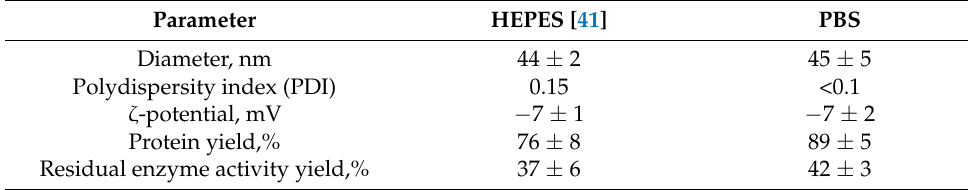
Figure 1. Physicochemical properties of Nano-SOD1 obtained. ( A ) Principal scheme for the synthesis of Nano-SOD1. ( B ) Particle hydrodynamic diameter distribution (SOD1/protamine/PGlu-PEG = 1:2:2 with glutaraldehyde (GA) as a cross-linker). ( C ) SOD1 release profile from a dialysis capsule with Nano-SOD1 obtained in HEPES and PBS buffers; 1 mL of Nano-SOD1 solution with specific activity of 13,500 U/mL was placed inside each dialysis capsule and 30 mL of PBS were placed outside the capsule. Table 1. Characteristics of Nano-SOD1 obtained in PBS and HEPES